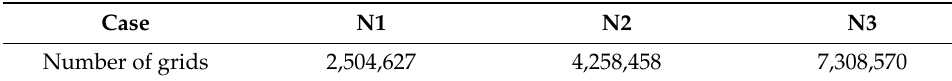
Table 2. The number of grids for the different schemes. Case